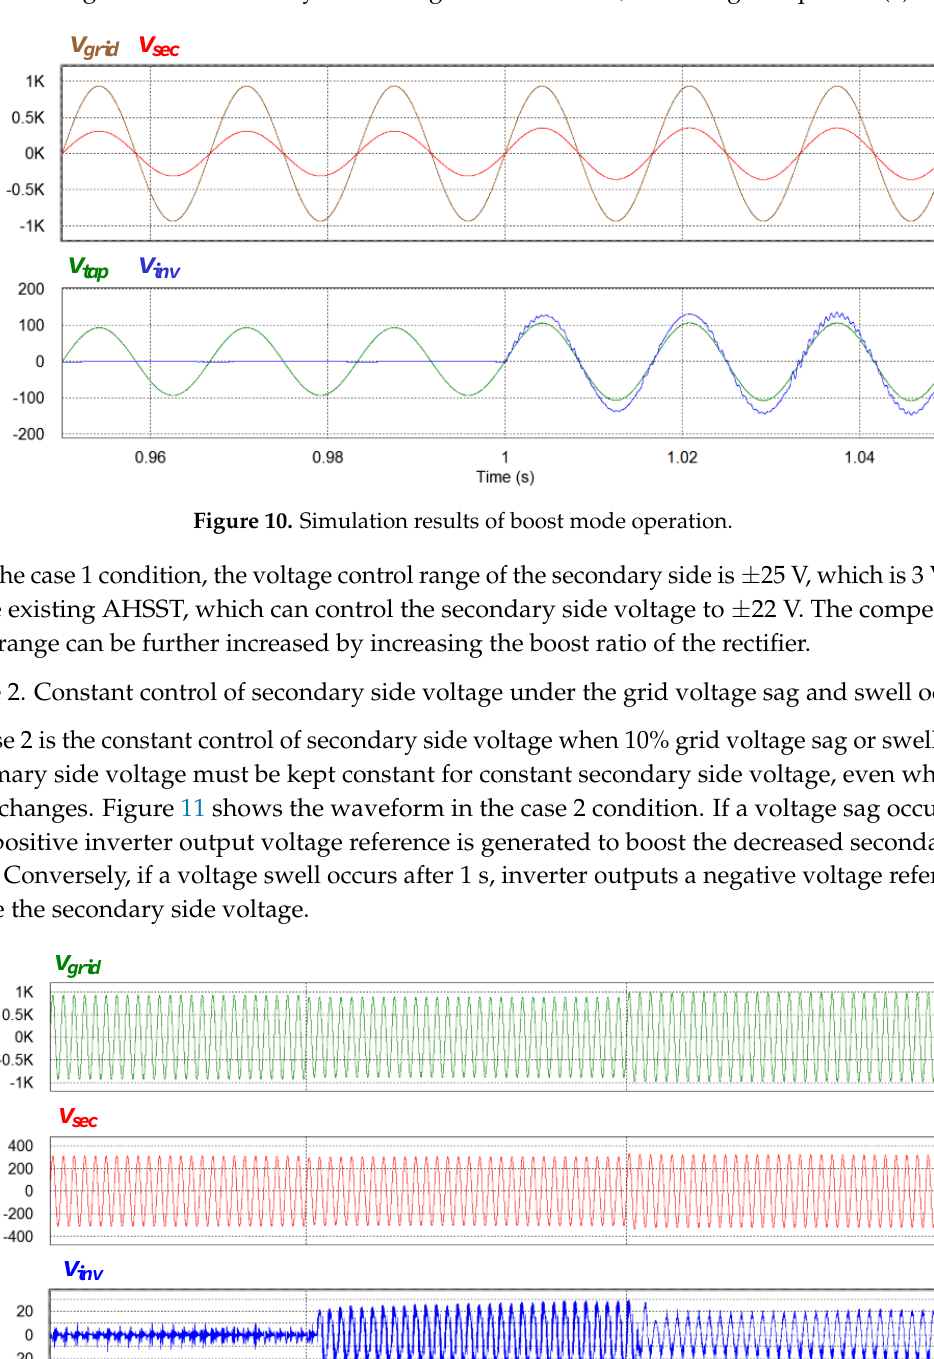
DC link Figure 12. Experimental setup.